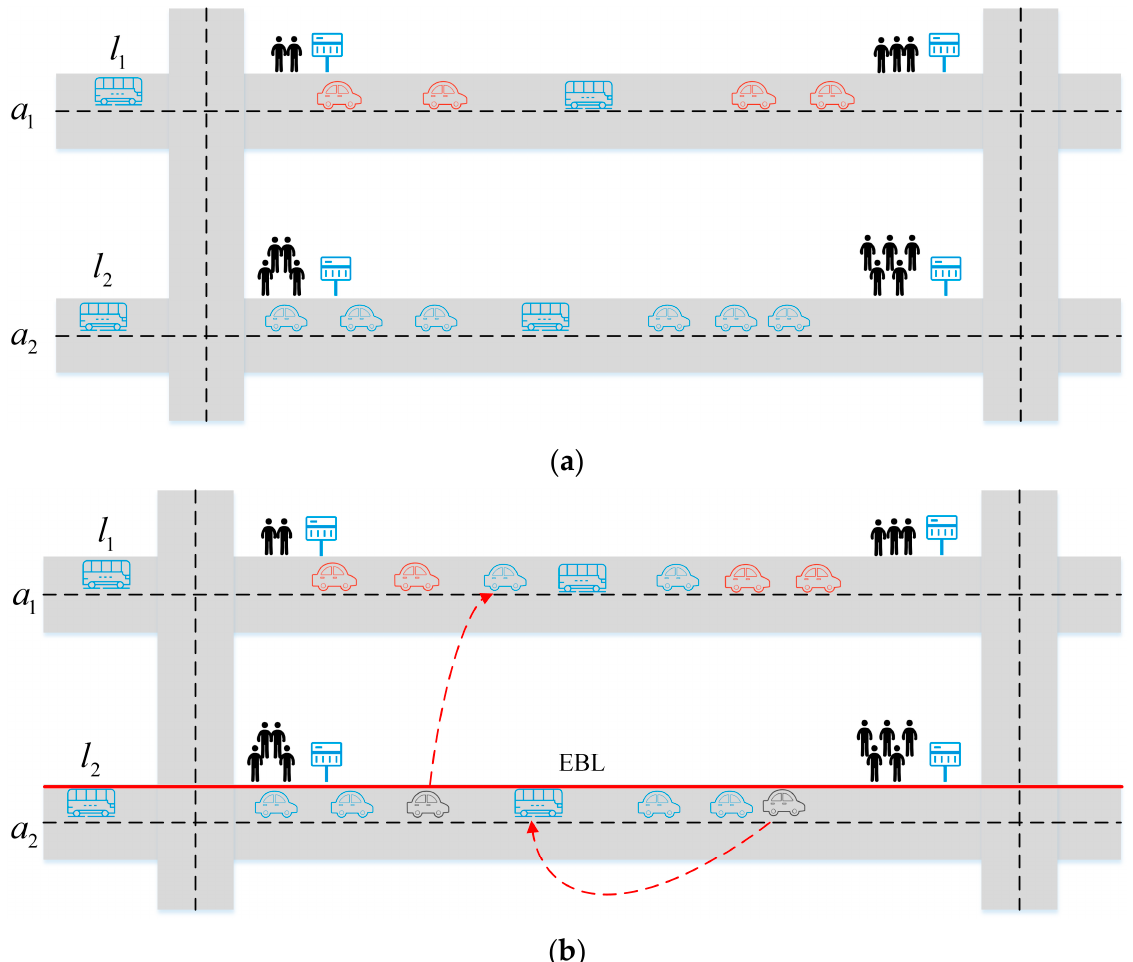
Figure 1. Impact of EBLs on the urban traffic network. ( a ) Traffic flow before setting EBLs. ( b ) Traffic flow after setting EBLs.